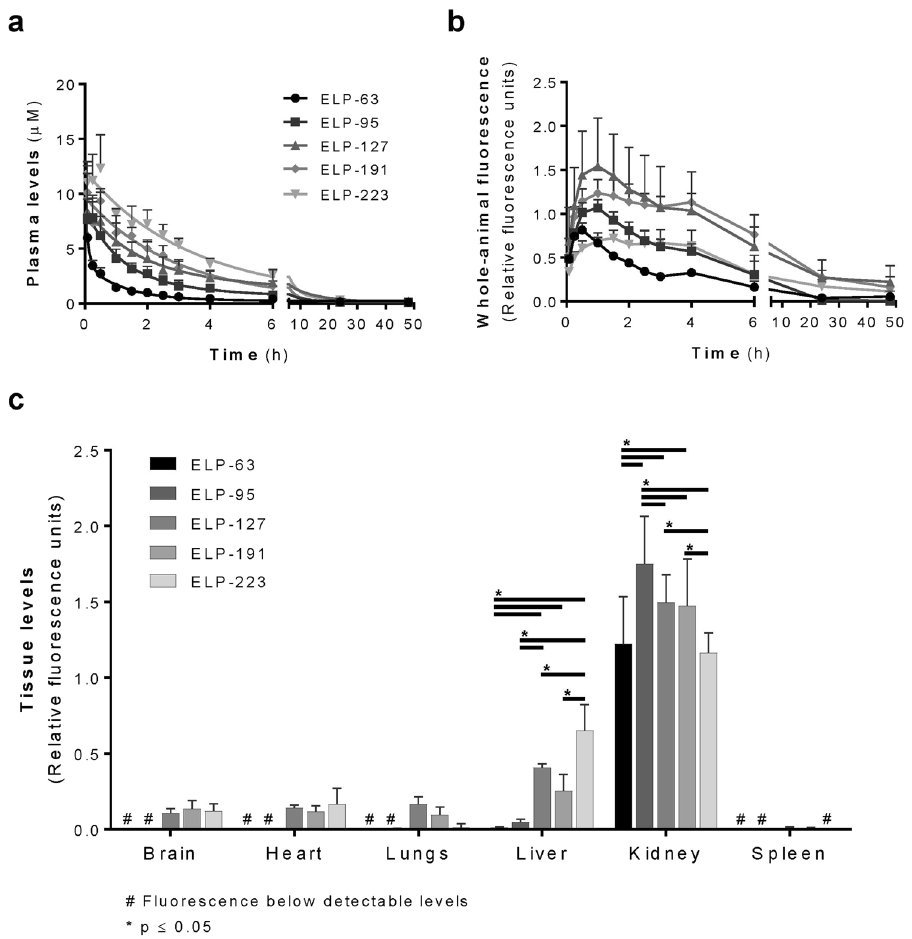
Figure 4. Plasma and Tissue Pharmacokinetics and Tissue Biodistribution of ELP Constructs. ( a ) Plasma levels of ELP proteins with fit lines representing a two compartment pharmacokinetic model fit. ( b ) Whole-animal clearance kinetics determined by non-invasive in vivo imaging of entire mice at each time point. ( c ) ELP tissue biodistribution 4 hours after administration. Values are mean ± SD, n = 4, except ELP-127 chronic study where n = 6. * Statistically significant difference between indicated groups as assessed by a two-way ANOVA with post hoc Tukey’s multiple comparison, p ≤ 0.05. # Polypeptide levels below detectable levels.